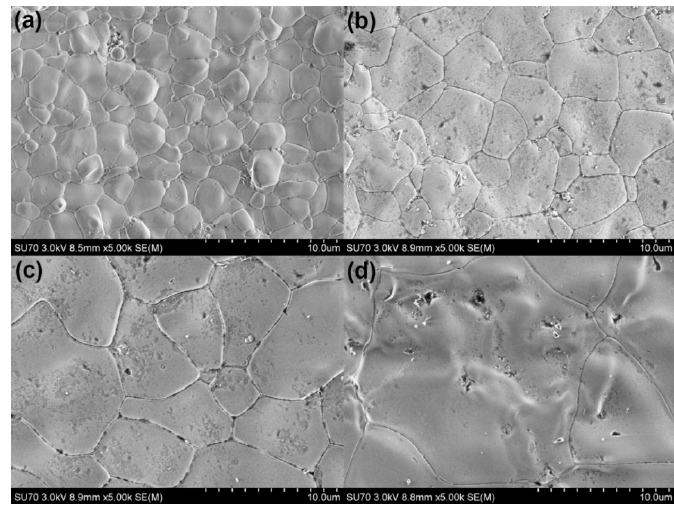
Figure 3. Scanning electron microscope images of 2Bi-8YSZ at various temperatures: ( a ) 1100 °C;